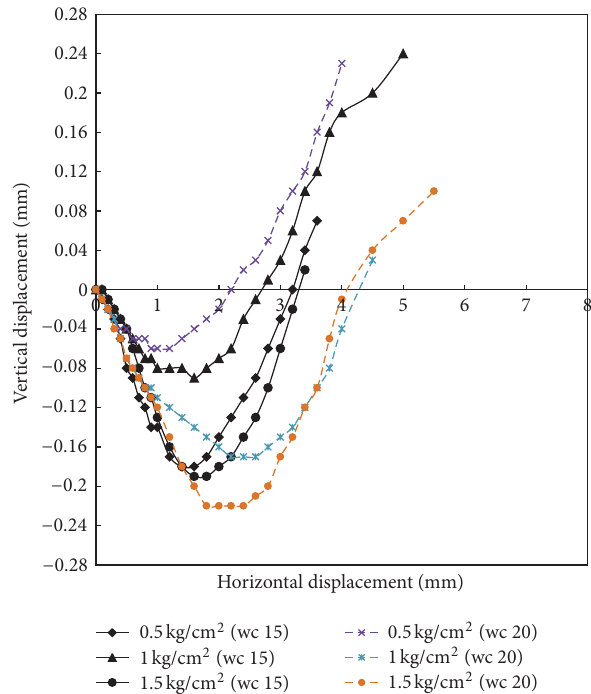
F8:Shearstressversushorizontaldisplacementobtainedfrom direct shear test.